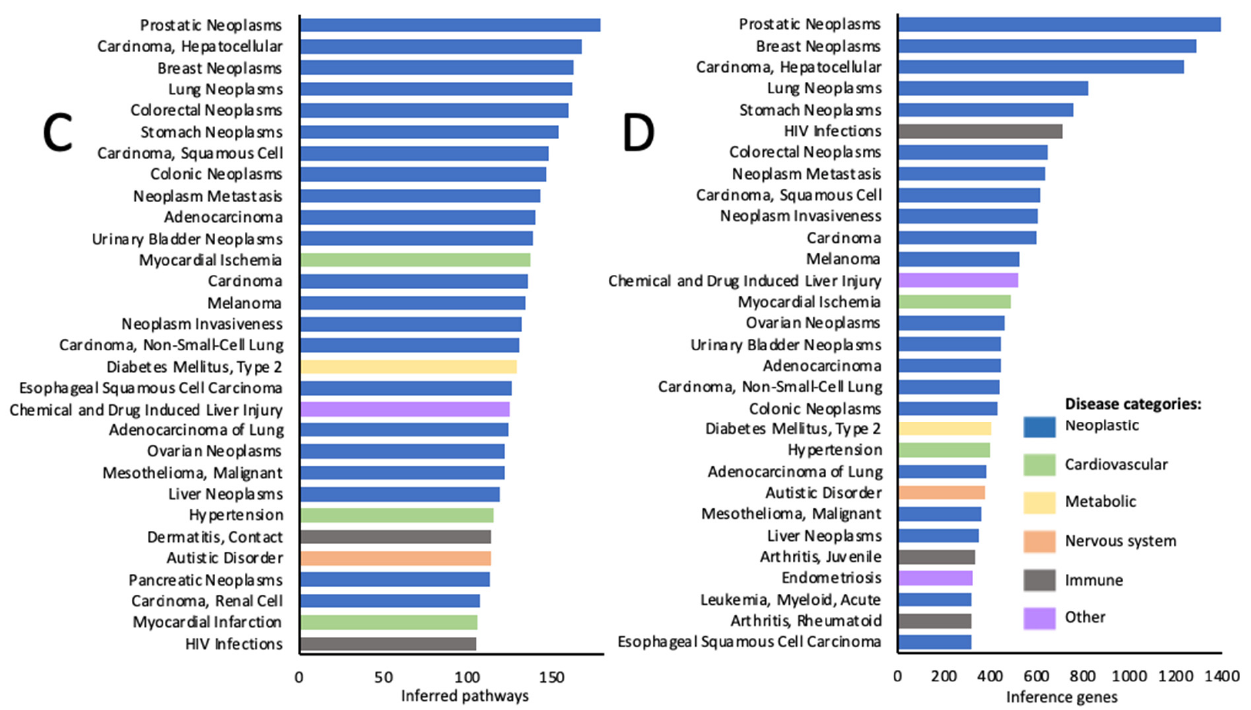
Figure 2. Top 30 disease categories out of 1850 associated with KEGG pathways ( A , B ), and out of 2481 associated with Reactome pathways ( C , D ) sensitive to chemical exposures. A and C—top ranking diseases identified based on the number of inferred pathways; B and D—top ranking diseases identified based on the number of inference